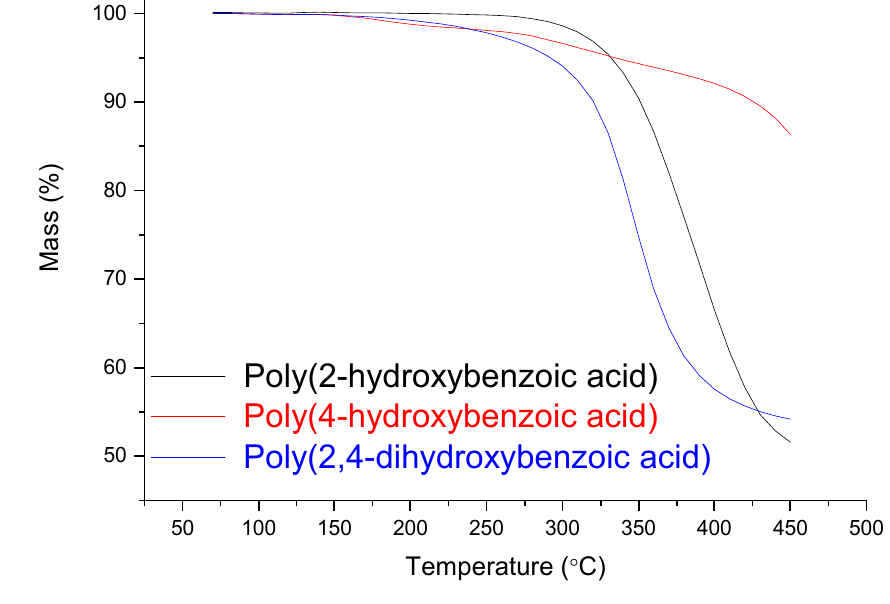
Figure 8. TGA curves of the oligomers.